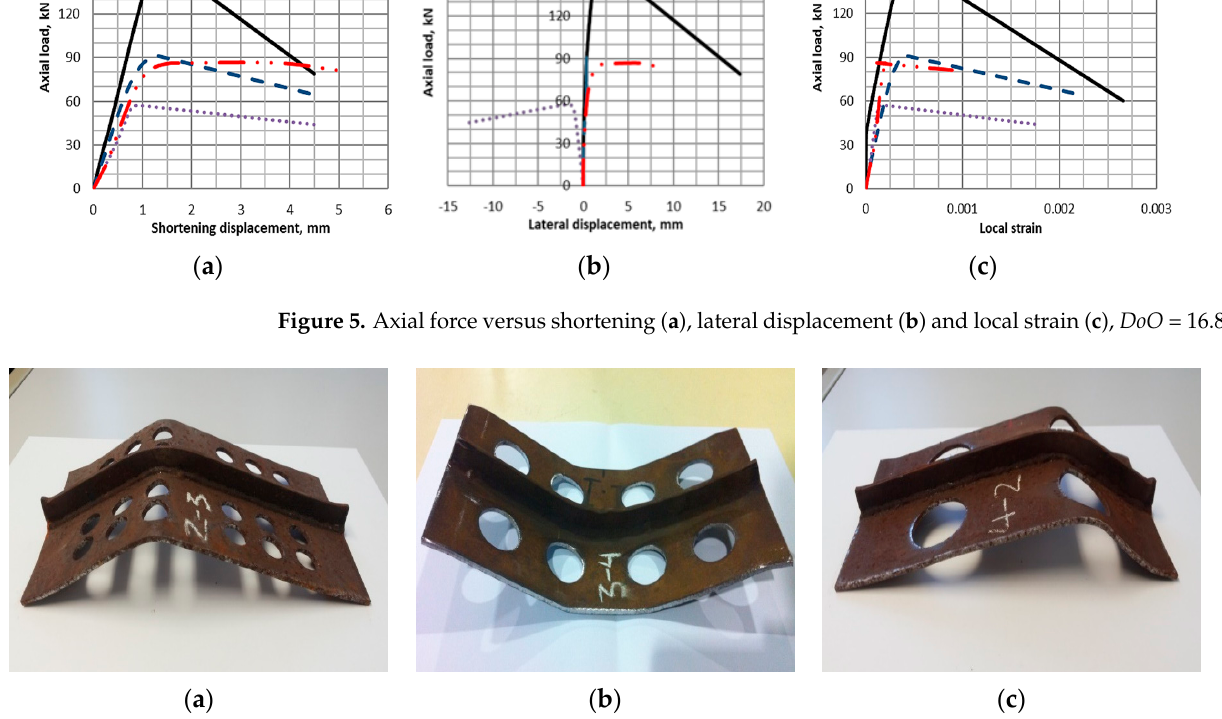
Figure 5. Axial force versus shortening ( a ), lateral displacement ( b ) and local strain ( c ), DoO = 16.80%.